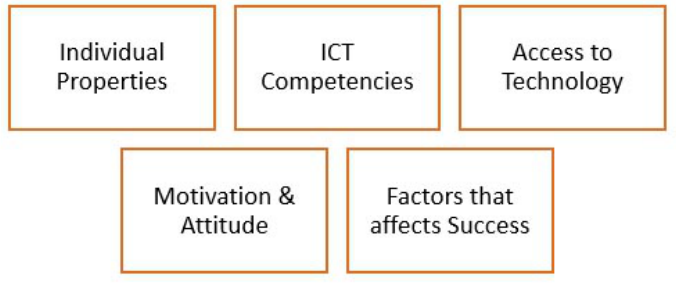
Figure 1 . e-Readiness scale